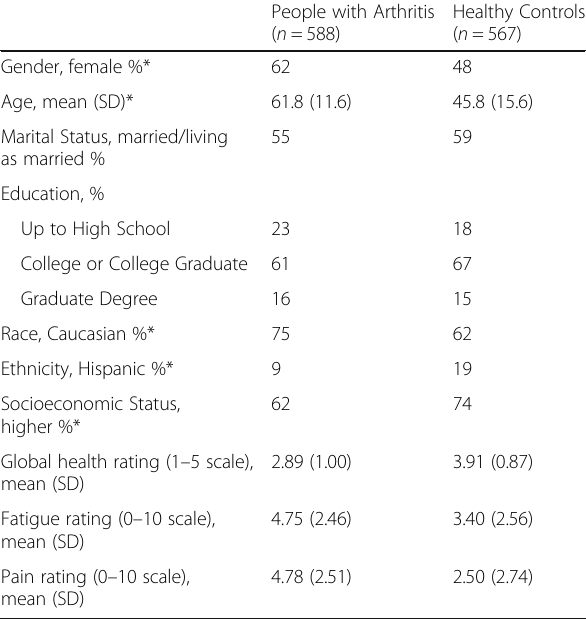
Table 1 Demographic characteristics and self-report ratings of people with arthritis and healthy controls People with Arthritis ( n =